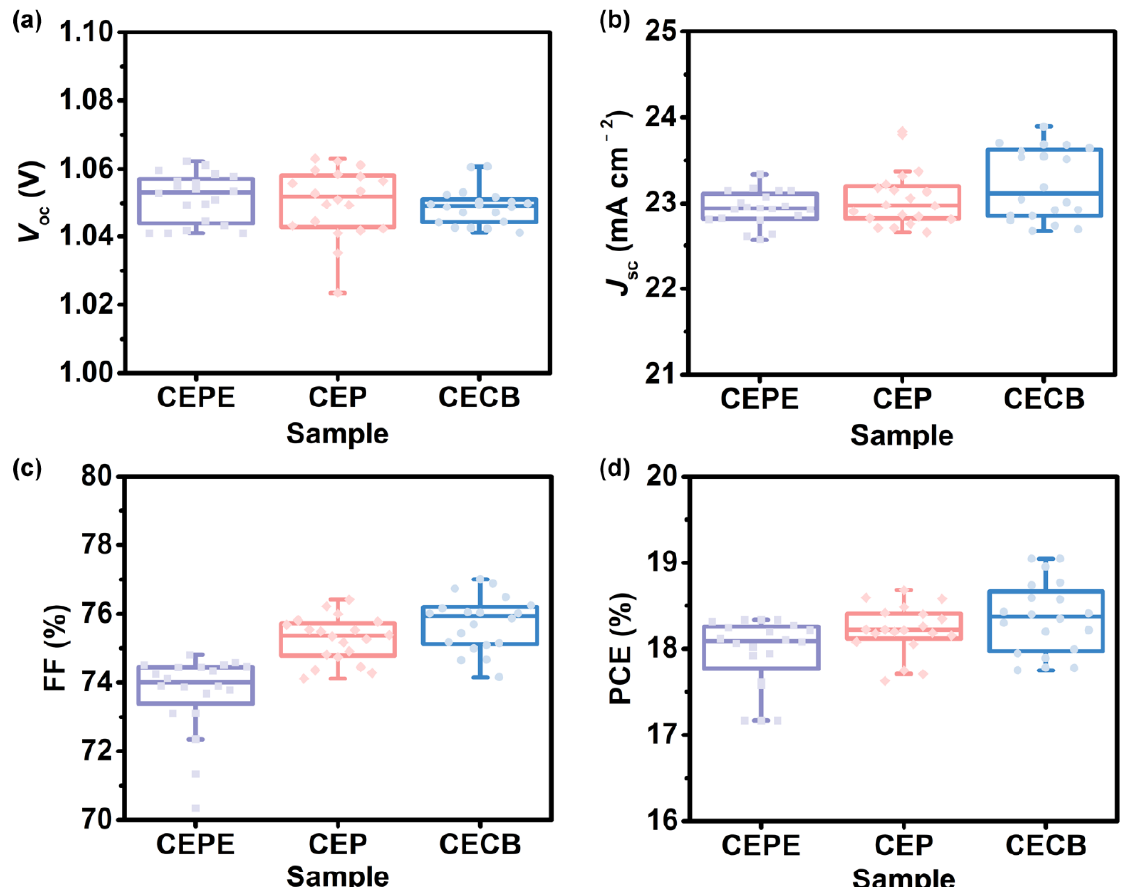
Figure 4. Photovoltaic performance of 20 devices based on different fullerene ETMs: ( a ) V oc , ( b ) J sc , ( c ) FF, and ( d ) PCE.